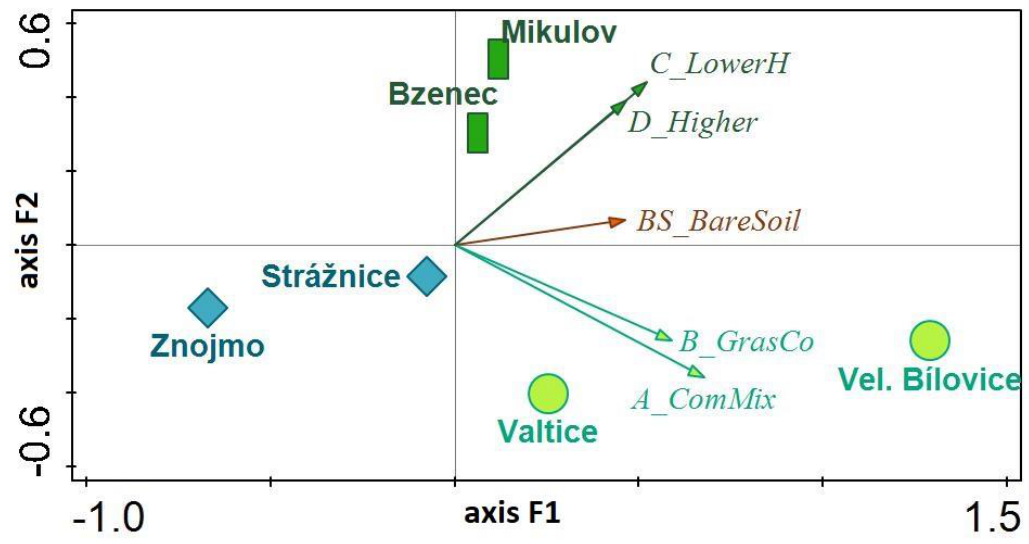
Figure 4. Ordination diagram of RDA analysis of variants of greening management within selected regions (pseudo F = 5.4, p = 0.001). According to the distances of the points presenting the localities from all arrows, the diagram is divided into groups showing some similarities. Arrows presenting the vegetation types with same or resembling direction indicate similarity in the use of the given type of vegetation. Explanatory notes: A_ComMi—commercial mixture; B_GrasCo—grass cover, C_LowerH—lower herbaceous level; D_Higher—higher herbaceous level; BS_BareSoil—bare soil inter-rows.